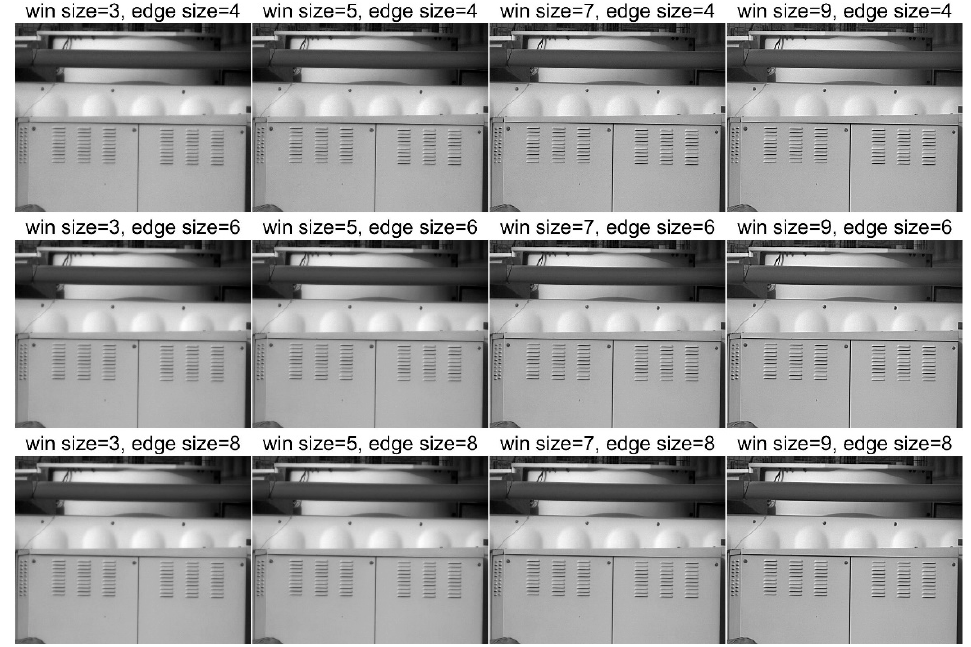
Figure 8. Enhancement results with different parameters .